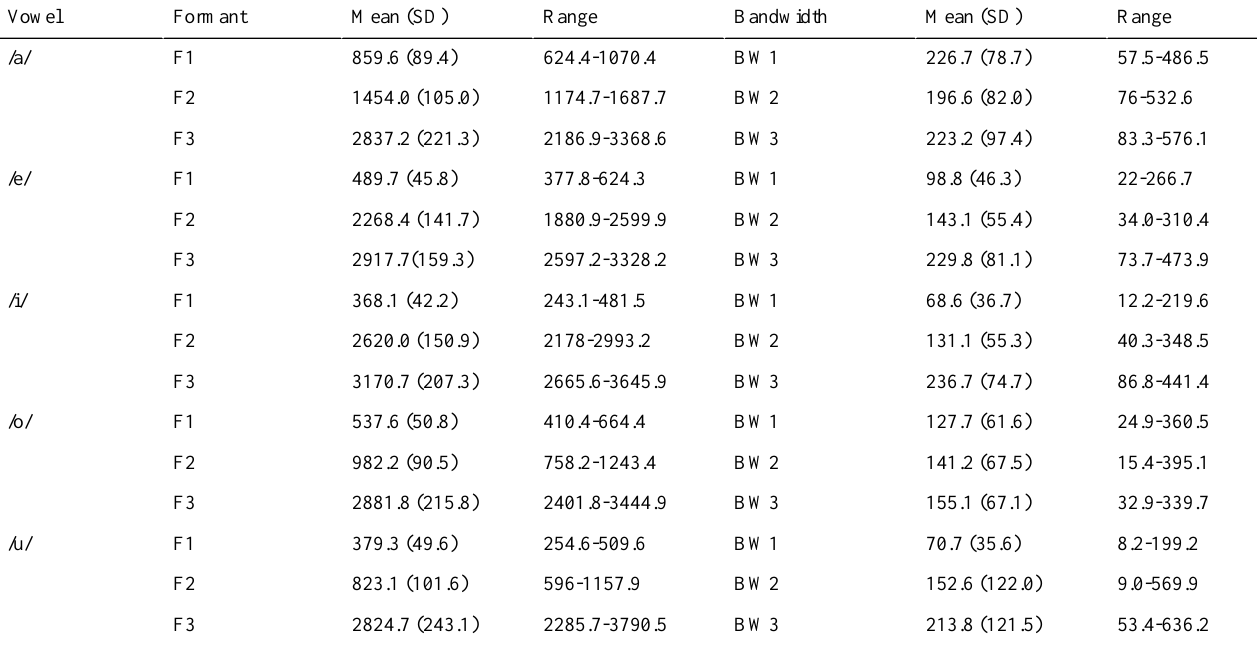
Table 3. Descriptive statistics of the formant frequencies and bandwidth of vowels on the female population